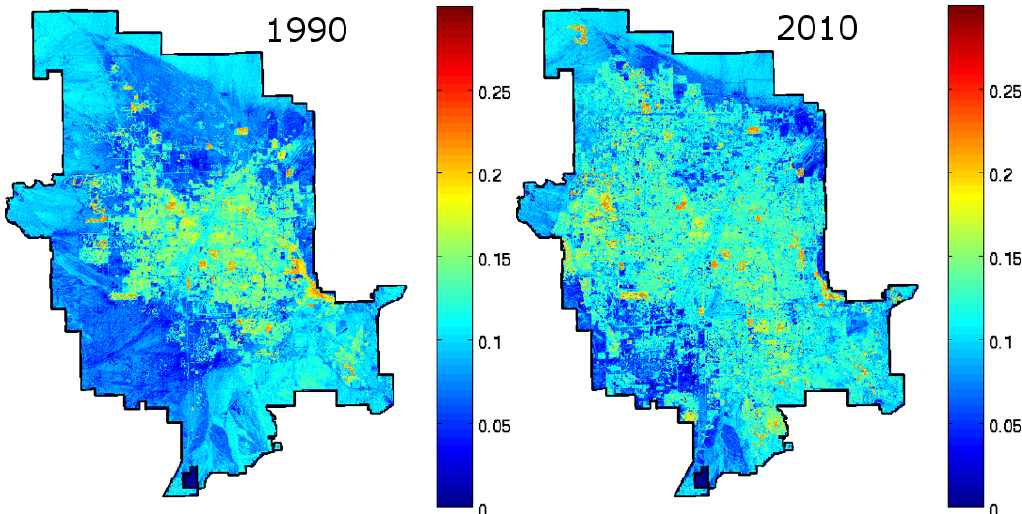
Figure 8. Change in the tree cover fraction between 1990 and 2010 in Las